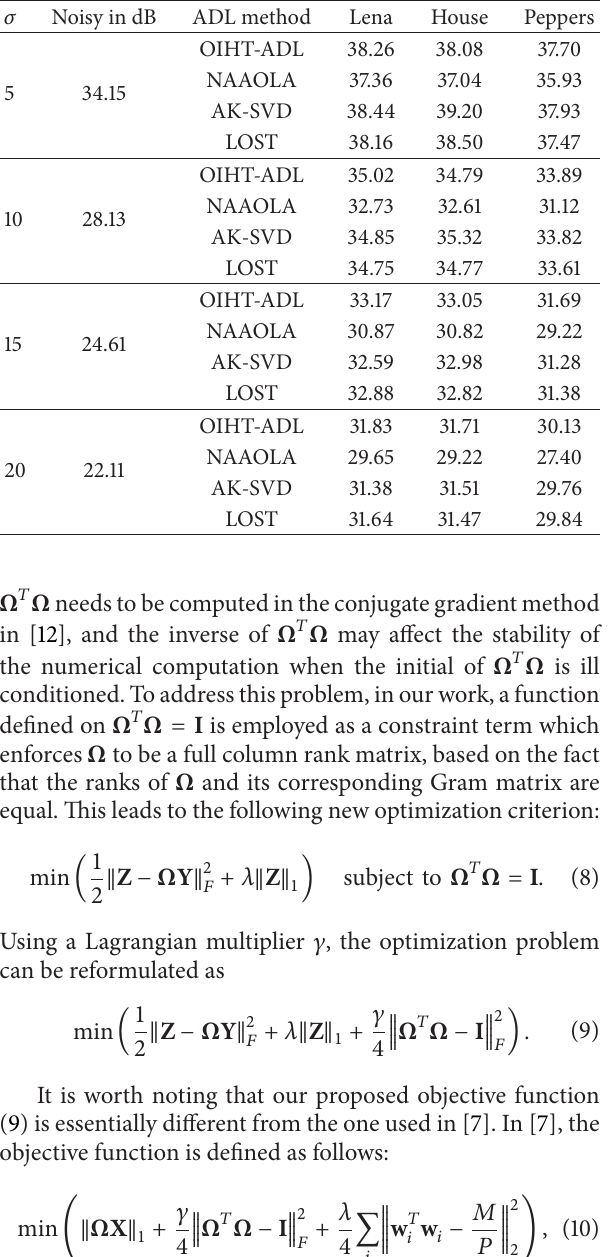
Table 1: Image denoising results (PSNR in